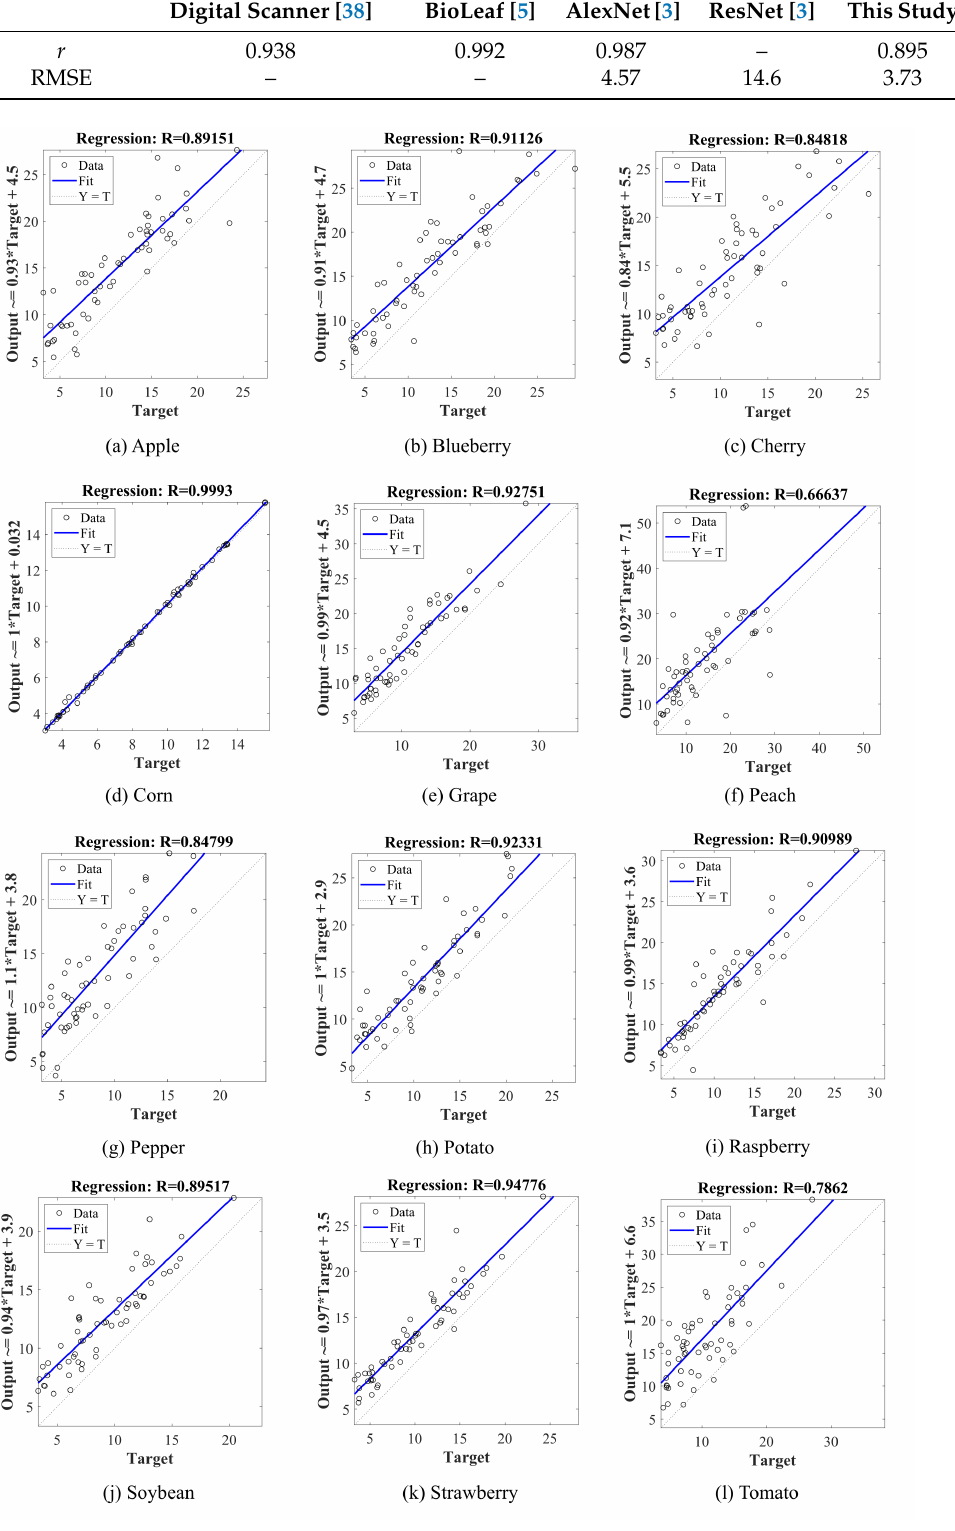
Table 3. Quantitative results provided by related work and our method considering soybean leaves.